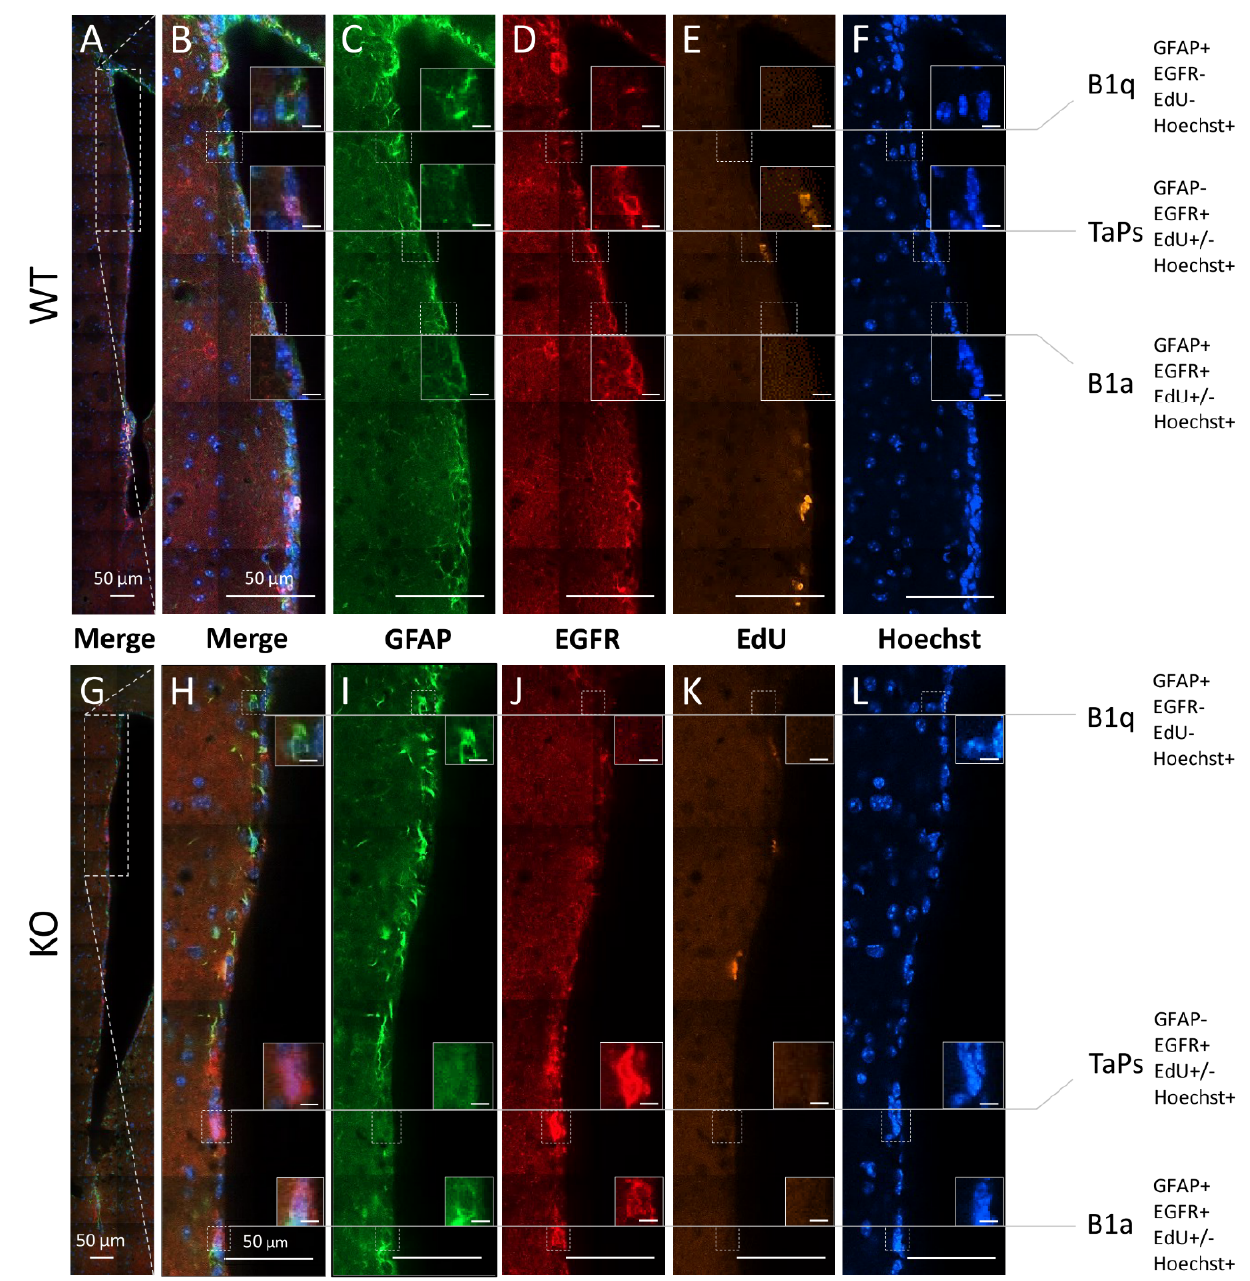
Figure 3. Subpopulations of precursor and progenitor/neural stem cells in the subventricular zone revealed by the combinatory multiple-epitope detection (confocal microscopy) of cellular markers and stainings. Immunoreactivity of GFAP (green) and EGFR (red). The detection of EdU-labelled proliferative cells (yellow) and Hoechst-staining-labelled cell nuclei (blue) were used to phenotype the precursors and progenitors in the dorso–ventral axes along the lateral walls of the SVZ neurogenic niches in the ( A – F ) WT and ( G – L ) cD2-KO mice: B1 quiescent precursors (B1q): GFAP(+), EGFR( − ), EdU( − ), and Hoechst(+); B1 active precursors (B1a): GFAP(+), EGFR(+), EdU(+) or EdU( − ), and Hoechst(+); transit-amplifying progenitors (TaPs): GFAP( − ), EGFR(+), EdU(+) or EdU( − ), Hoechst(+), and “Others”: GFAP( − ), EGFR( − ), EdU(+) or EdU( − ), and Hoechst(+) (not shown). EdU—(5-ethynyl-2 (cid:48) -deoxyuridine)-labelling of proliferating cells; EGFR—epidermal growth factor receptor; GFAP—glial fibrillary acidic protein; Hoechst—dye for nuclei staining. Scale bar in small inserts of 5 µ